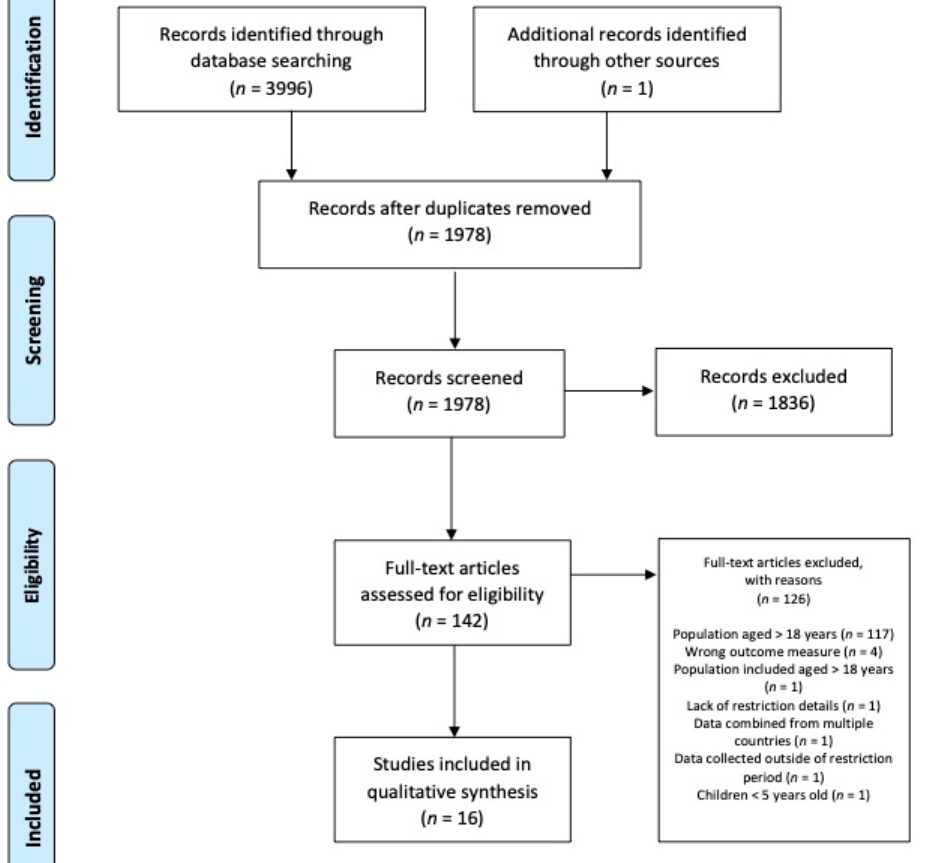
Figure 1. Schematic flow diagram of the integrative review process.